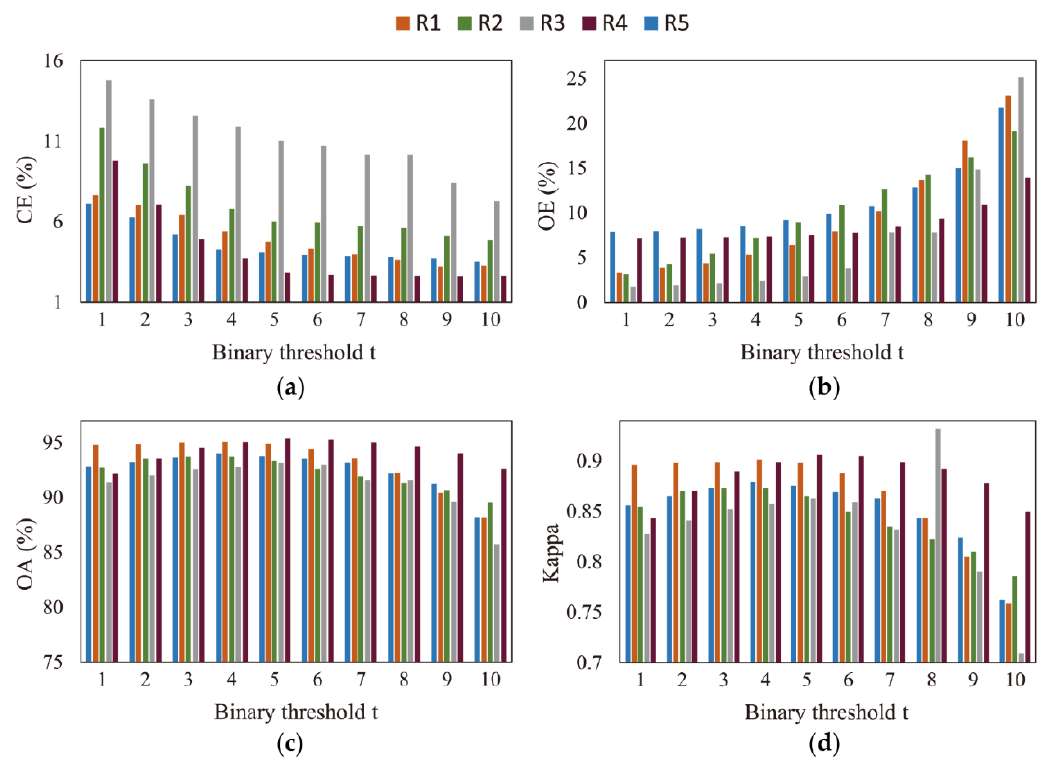
. ( a ) commission error (CE); ( b ) 𝑡𝑡